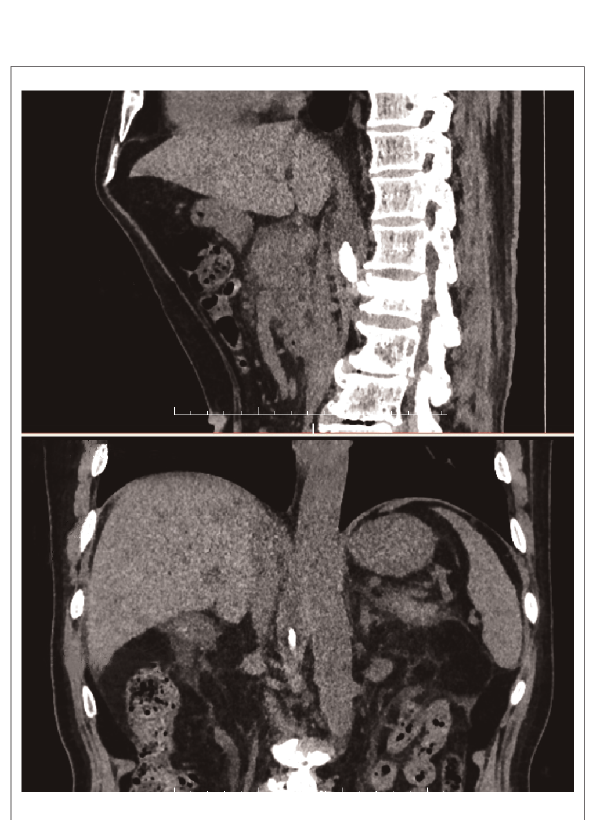
FIGURE 4 Postoperative 3D reconstruction showing that the cement was located in the right anterior of L1 vertebra, adjacent to the pancreas.